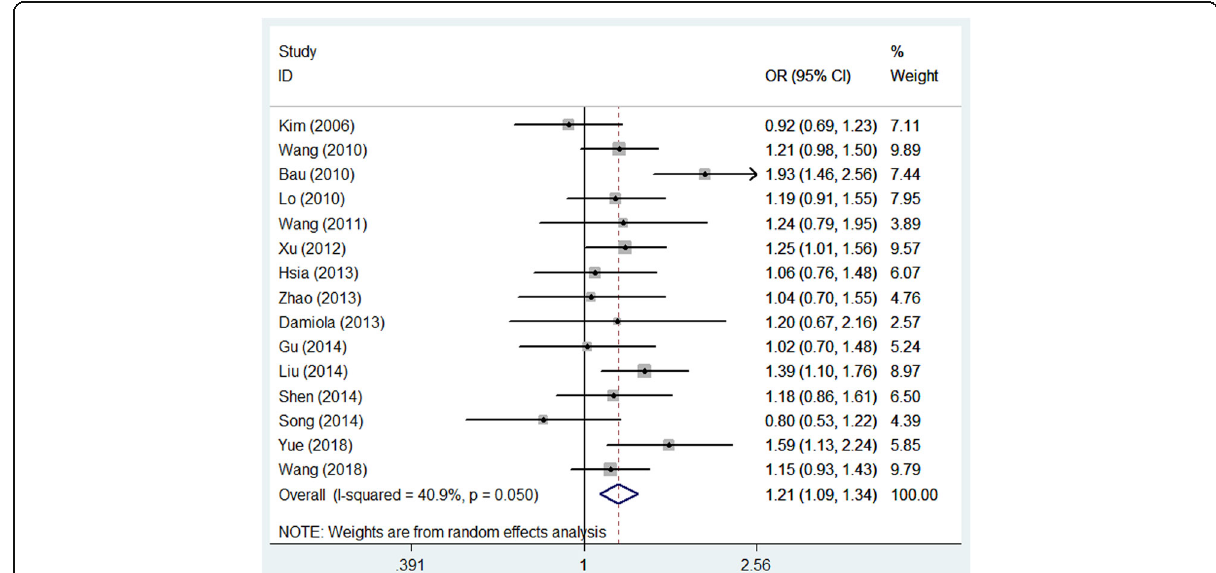
Fig. 1 Forest plot of the association between the rs189037 polymorphism of ATM and cancer in the dominant genetic model (GG + GA vs.